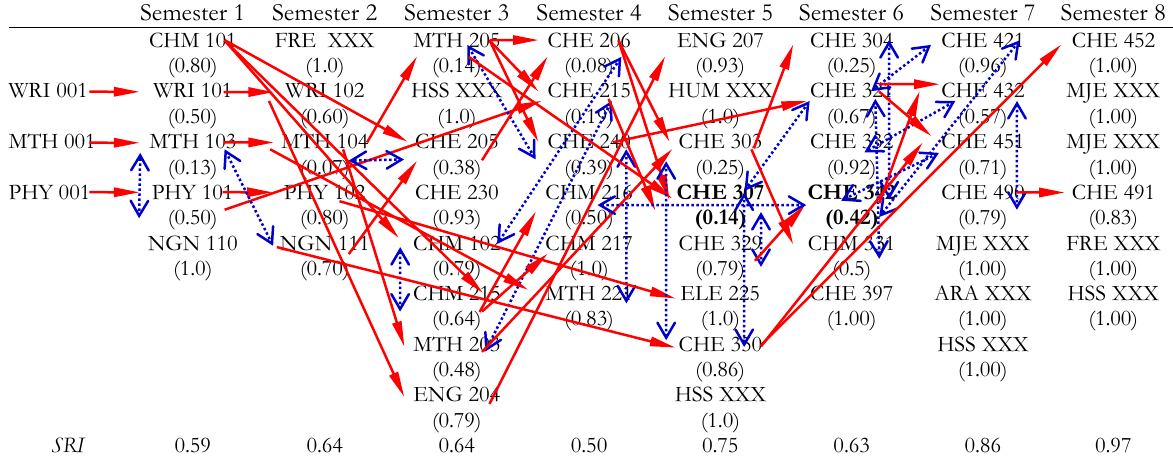
Figure 1. Relaxation index for each semester in the study plan for the Chemical, Civil, & Mechanical Engineering at the American University of Sharjah Table 4 . The study plan for the Chemical Engineering Department at the American University of Sharjah with pre-requisites (solid arrows), co-requisites (dashed two-directional arrows), course relaxation indices (numbers in parentheses), and semester relaxation indices (numbers is the last row) (Darwish, 2011)